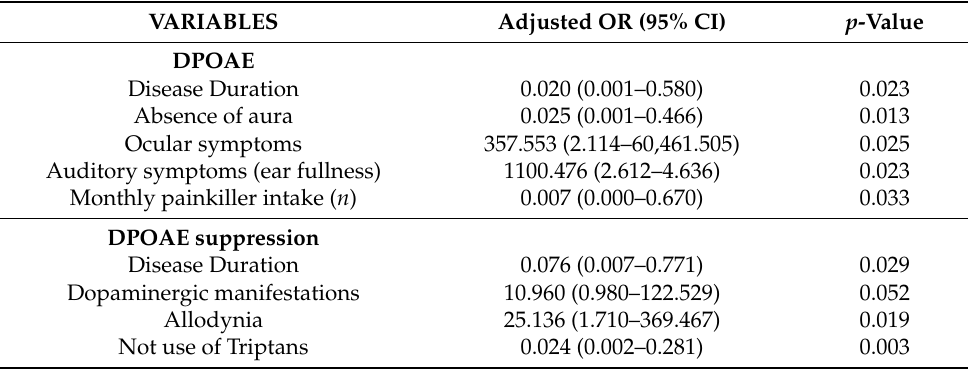
Table 3. Correlation between audiological variables and clinical